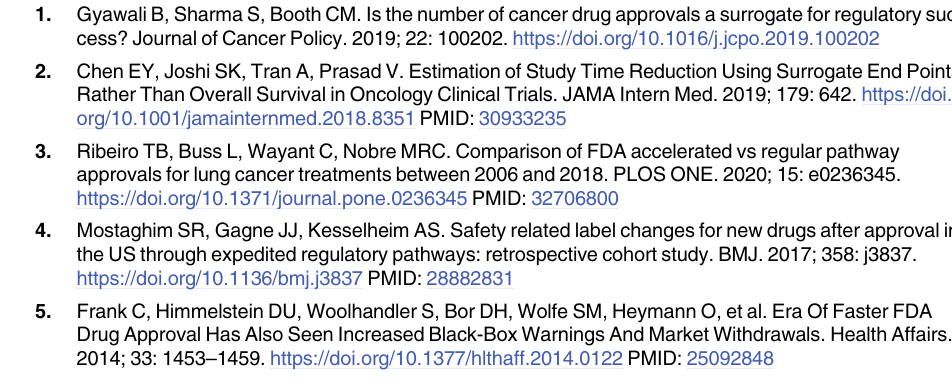
S2 Table. Sensitivity analysis for the correlation and concordance between the studies with the optimal threshold calculated with ROC curve analyses for ASCO-VF v2. S3 Table. Sensitivity analysis for the concordance and the correlation between the studies considering studies with the same evaluated endpoints only. S4 Table. Predictors of substantial clinical benefit on univariable logistic regression for all